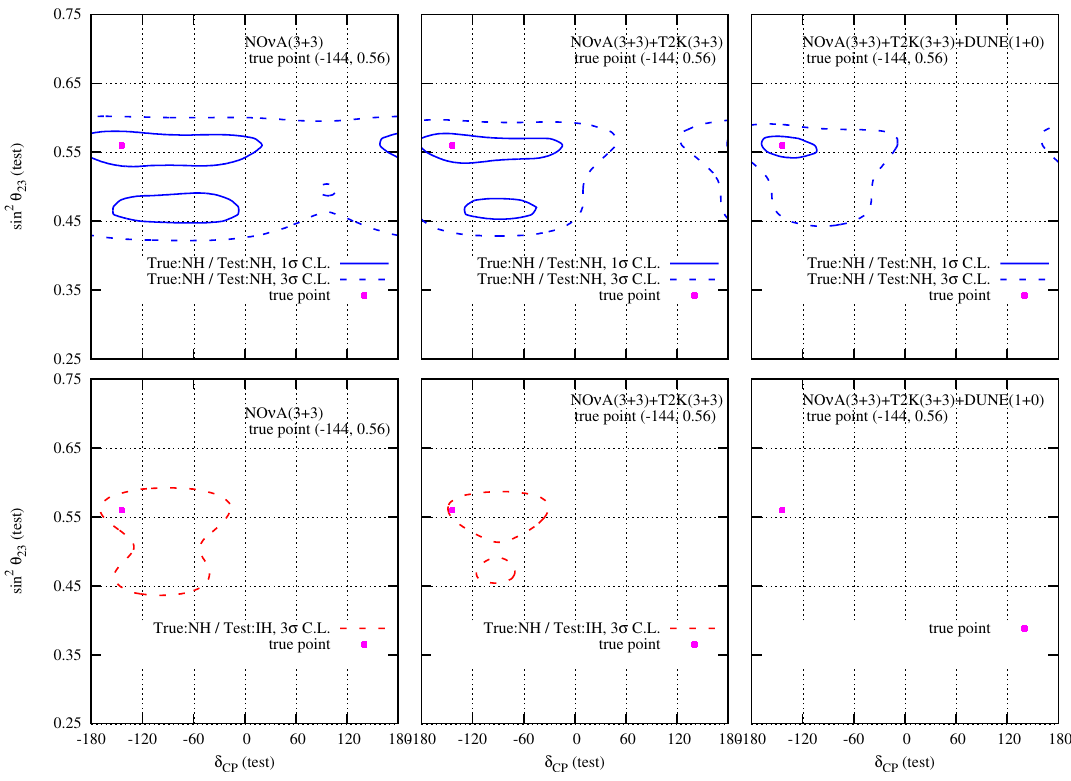
Figure 3 . Allowed regions in sin 2 (cid:18) 23 (cid:0) (cid:14) cp parameter space assuming the HO solution is correct. The left, middle and right columns are for NO (cid:23) A (3 (cid:23) + 3(cid:22) (cid:23) ), NO (cid:23) A (3 (cid:23) + 3(cid:22) (cid:23) ) + T2K (3 (cid:23) + 3(cid:22) (cid:23) ) and NO (cid:23) A (3 (cid:23) +3(cid:22) (cid:23) ) + T2K (3 (cid:23) +3(cid:22) (cid:23) ) + DUNE (1 (cid:23) ) respectively. The top (bottom) row is for test NH